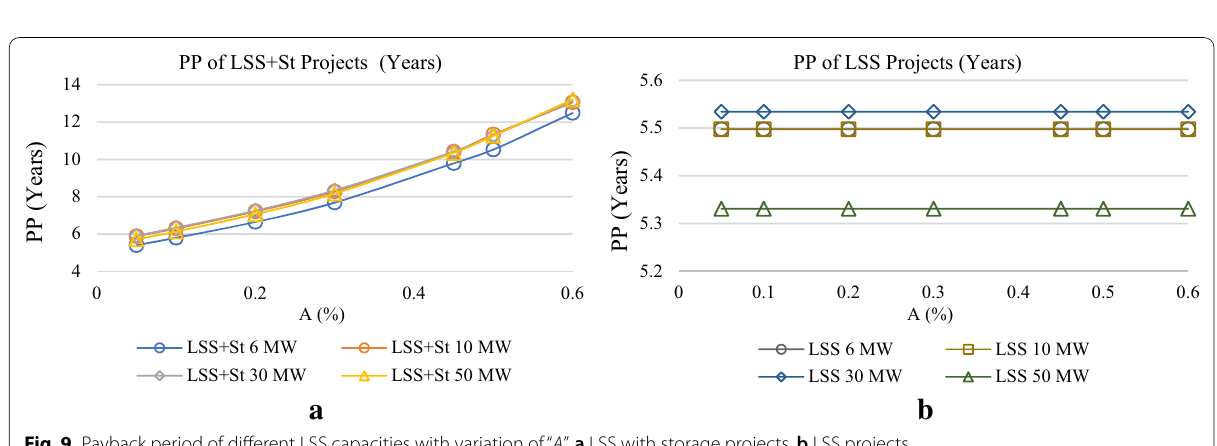
Fig. 9 Payback period of different LSS capacities with variation of “ A ”. a LSS with storage projects, b LSS